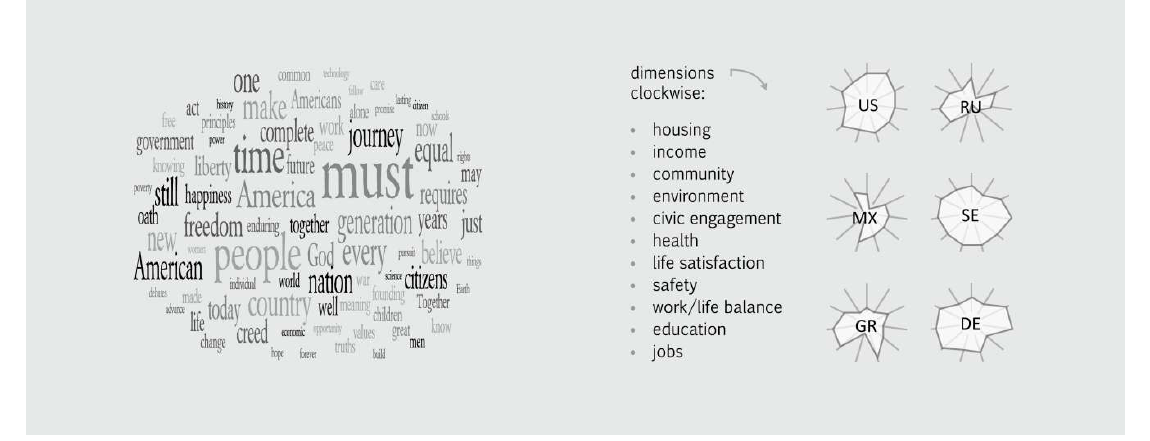
Figure 5: Examples of a word cloud for a political speech (left) and a statistical radar chart (right), visualizing the OECD Better Life Index for six different countries (cf. (cid:1)